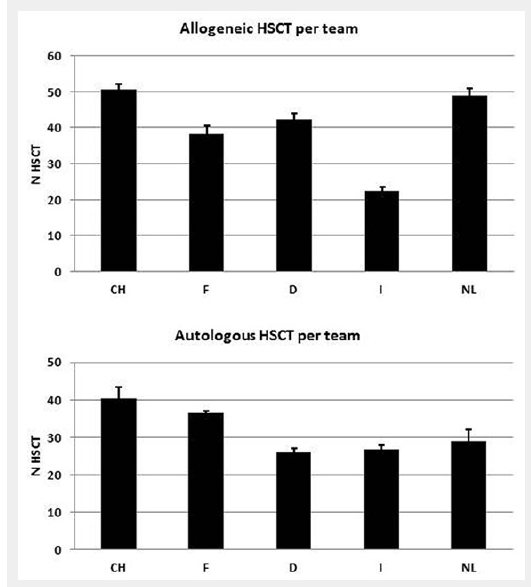
Average annual number of allogeneic and autologous HSCT per transplanting team. 7a: allogeneic HSCT. 7b: autologous HSCT (CH: Switzerland, F: France, D: Germany, I: Italy, NL: the Netherlands).